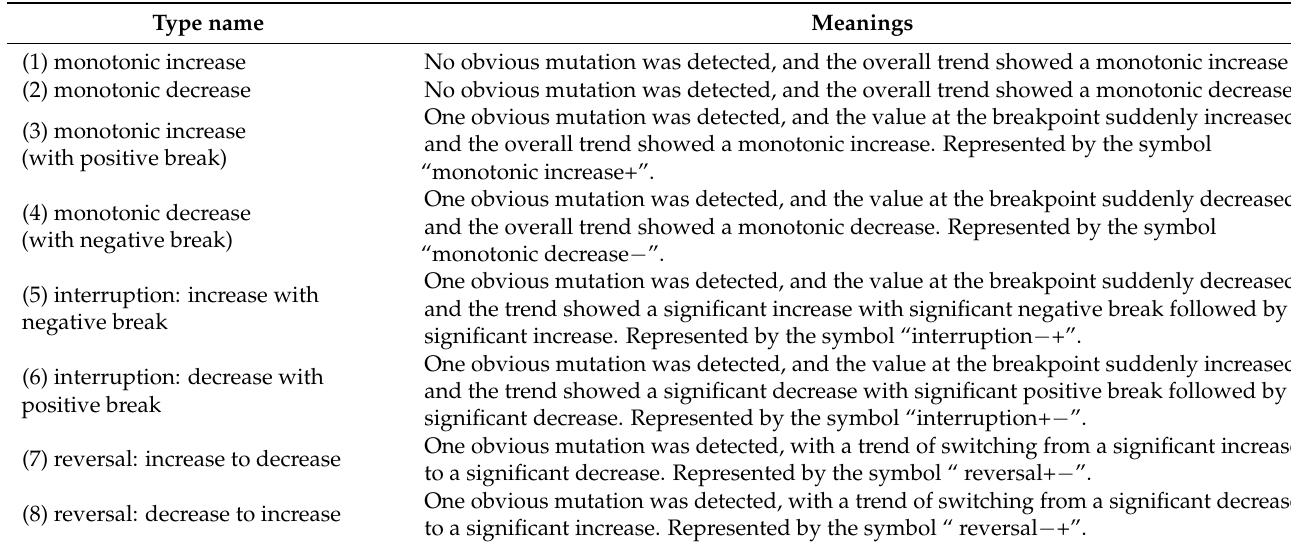
Table 3. Types and meanings of trend mutation in